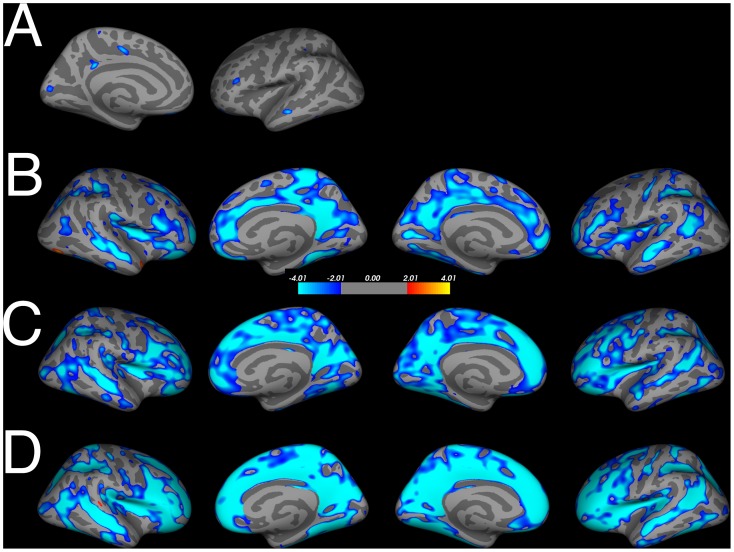
Overlap of testosterone and estradiol levels (corrected for age), age effects corrected for testosterone levels and general age-effects on cortical thickness.A. Estradiol (pmol) related thinning. B. Testosterone (Zlog) related thinning. C. Age-related thinning corrected for testosterone levels (Zlog). D. Age-related thinning. FDR-corrected, p<.05 in all figures.